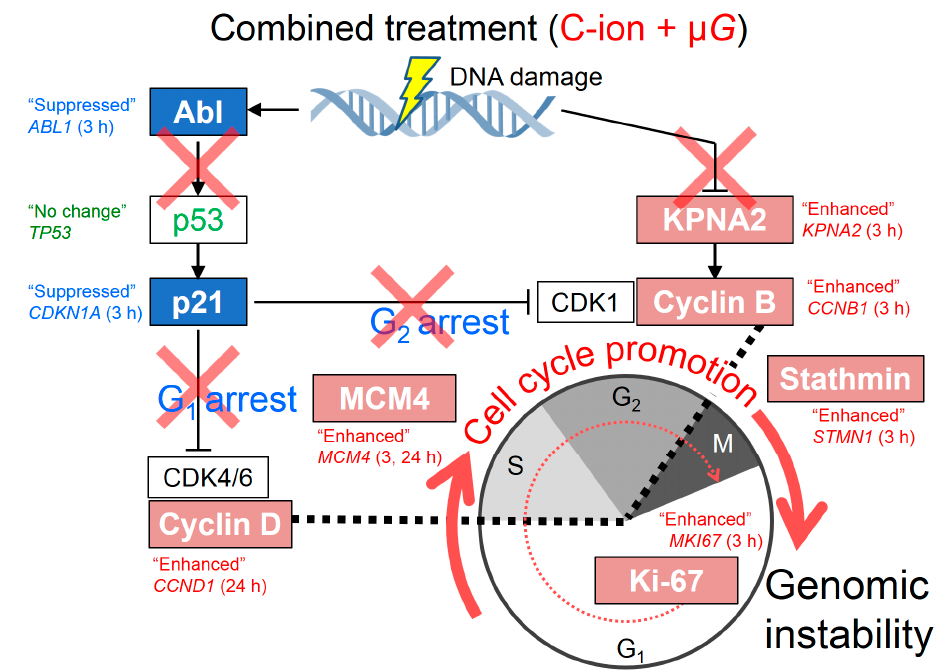
Figure 4. Schematic representation of the proposed model of cell cycle-related pathway modified by combined effect of C-ion exposure with simulated μ G in 1BR-hTERT human fibroblasts. The pink column shows cell cycle-promoting genes and blue column indicates cell cycle-suppressing ones.